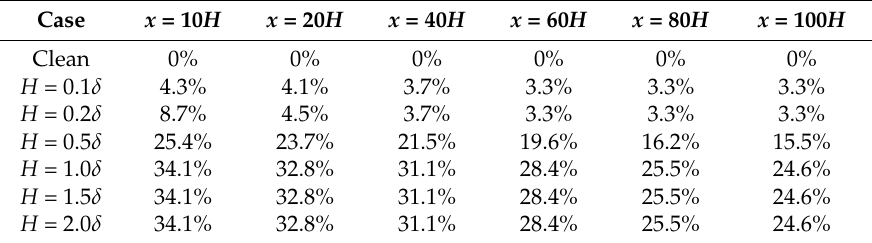
Table 5. Relative increase in near-wall (y/ H < 1) momentum for different